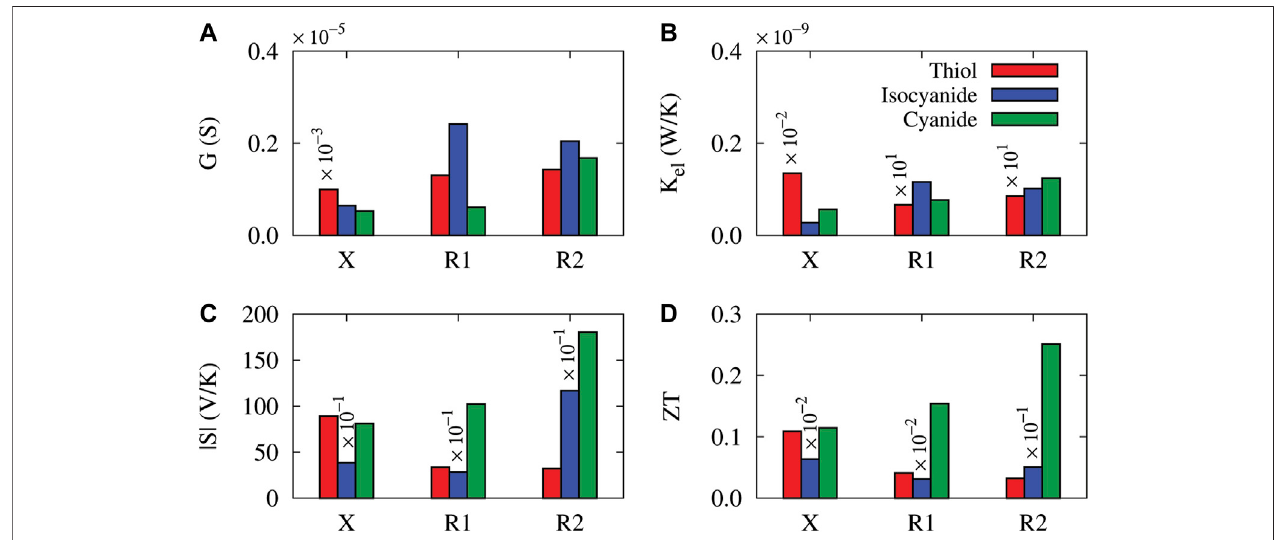
FIGURE 7 | The electrical conductance (A) , electronic thermal conductance (B) , absolute value of the thermopower (C) and fi gure of merit (D) of the unperturbed molecularjunction(labeledX),and themoleculeperturbed withtheaminesidegroupinR1and R2positionsarecomparedat T (cid:1) 300 K.Thecoupling ofthemoleculeto the Au electrodes was mediated by thiol (red), isocyanide (blue) and cyanide (green) anchoring groups.